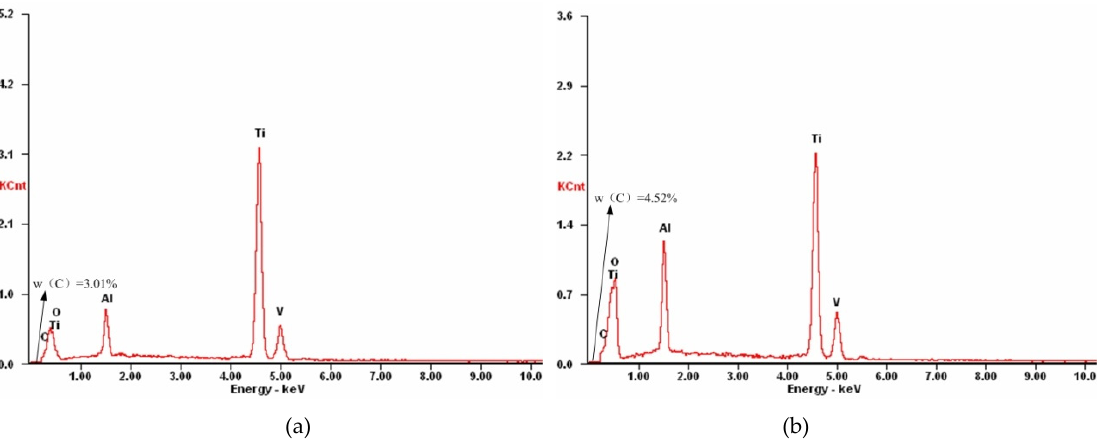
Figure 4. EDS of the titanium alloy sample surfaces before and after heated in air. (a) Before experiment; (b) after experiment.